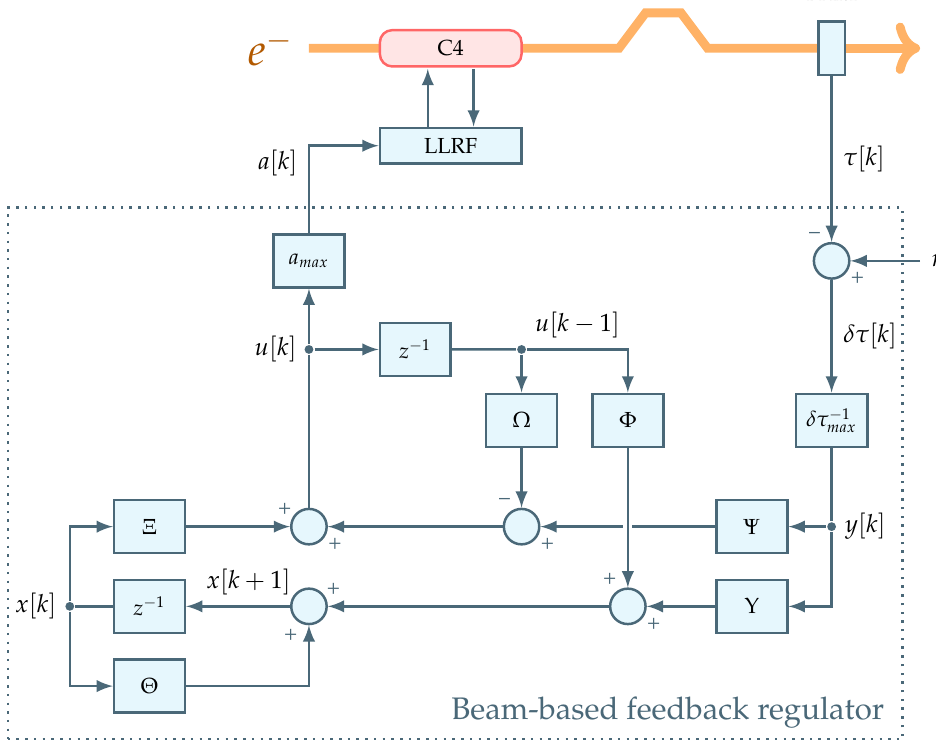
Figure 3. Beam-based feedback loop structure at